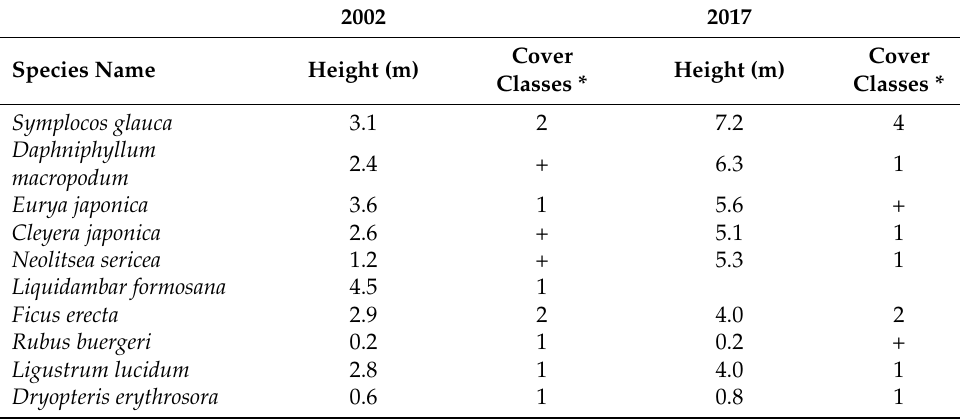
Table 2. Height and cover classes of major understory vegetation